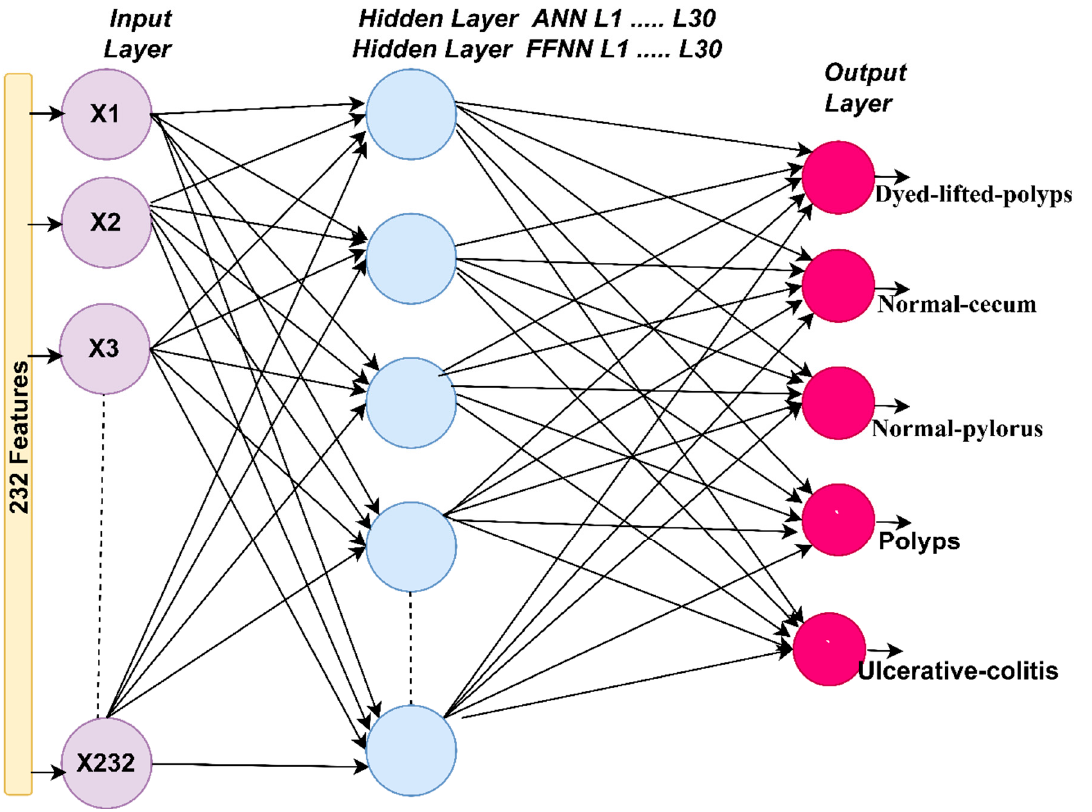
Figure 5. Structure of neural network algorithms for classifying the endoscopy image dataset of lower gastrointestinal diseases.